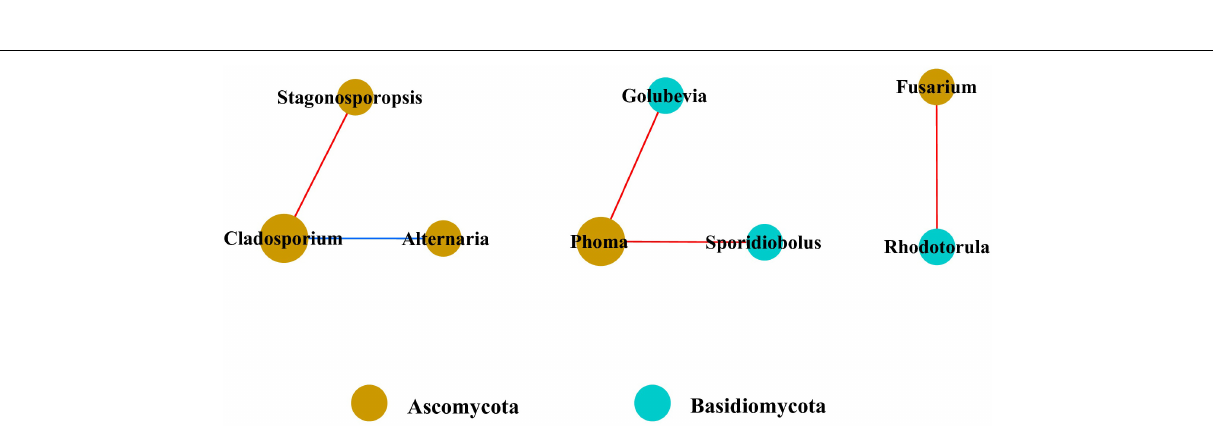
FIGURE 7 | Co-occurrence network of fungi at genera level. Only p values less than 0.05 and corrections coefficients higher than 0.6 were constructed in the network. The size of each node is proportional to the number of connections, the color of each node is correlates with taxonomy. Blue edges indicate positive correlations, and red edges indicate negative